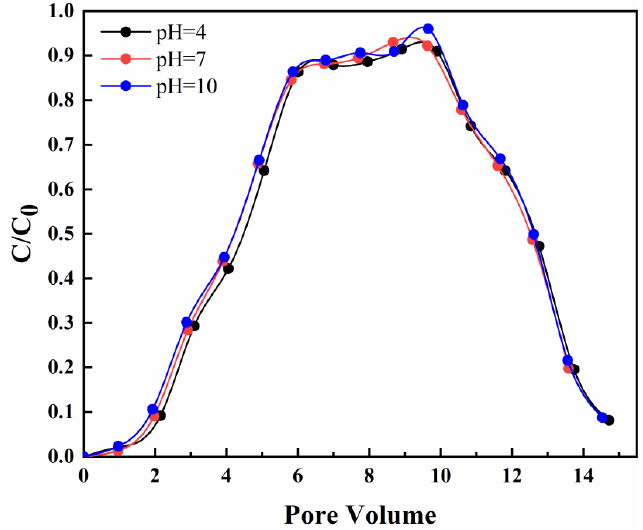
Figure 4. The influence of the pH value on the vertical migration of PHE in soil.